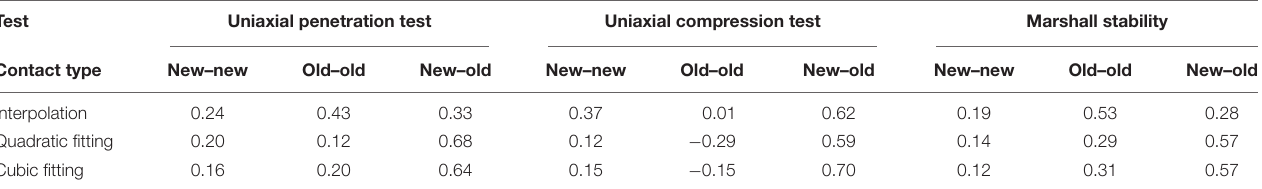
TABLE 9 | Data of